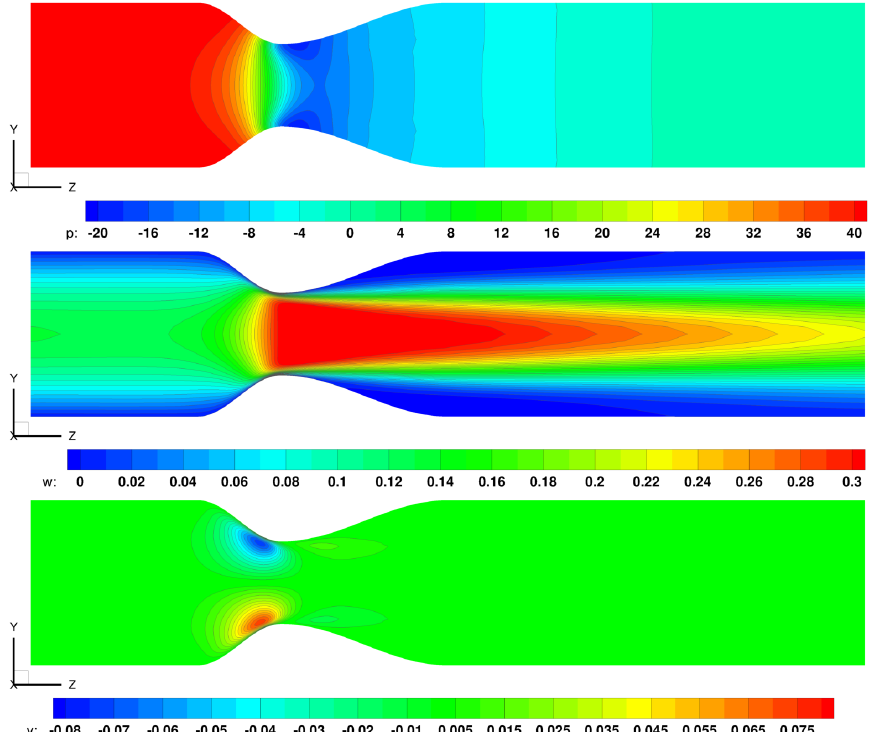
Figure 13. Flow rate Q = 2.0 cm 3 /s—Pressure, axial and radial velocity contours (from the